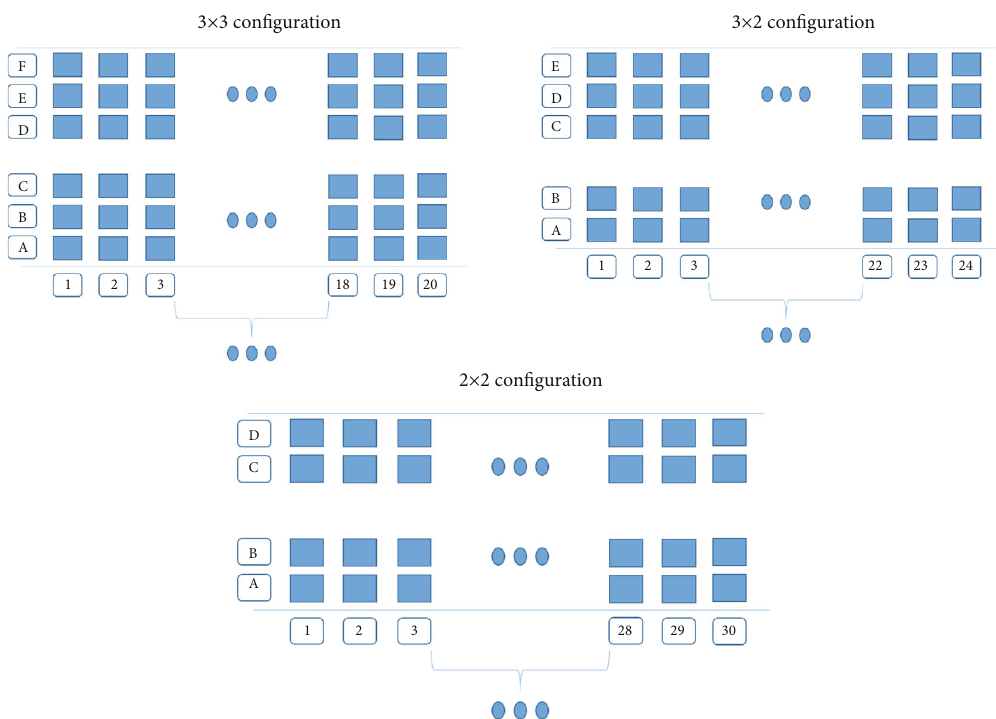
Figure 1: Aircraft con fi guration for case